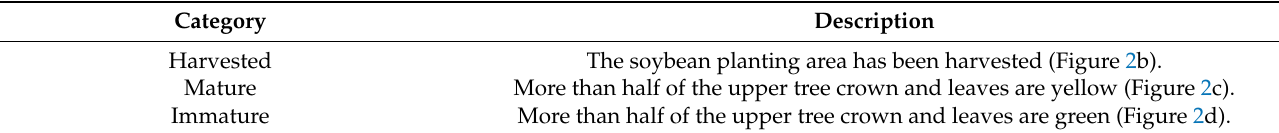
Table 3. Criteria for determining the maturity of soybean plots.